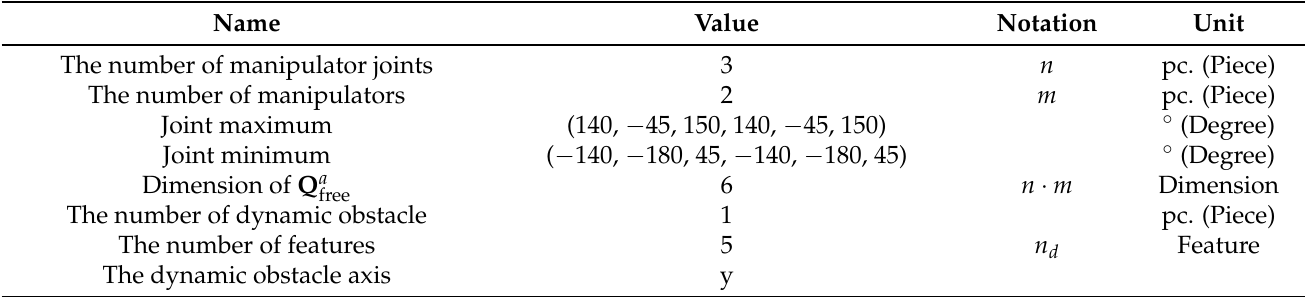
Table 1. Parameters of the 3DOF manipulator and environment.